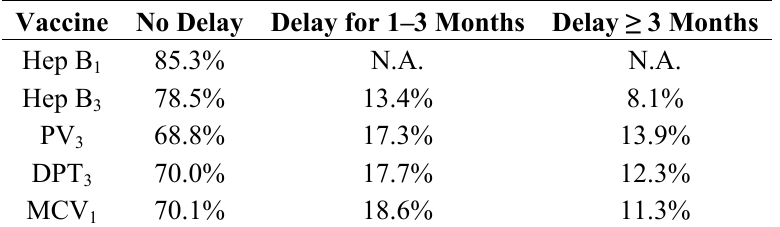
Table 8. Vaccination delay for the 2010 birth cohort.